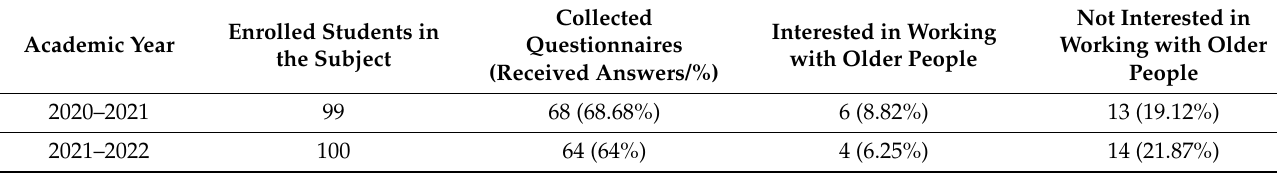
Table 1. List of students’ responses on whether they would like to work in areas related to old age and older adults.